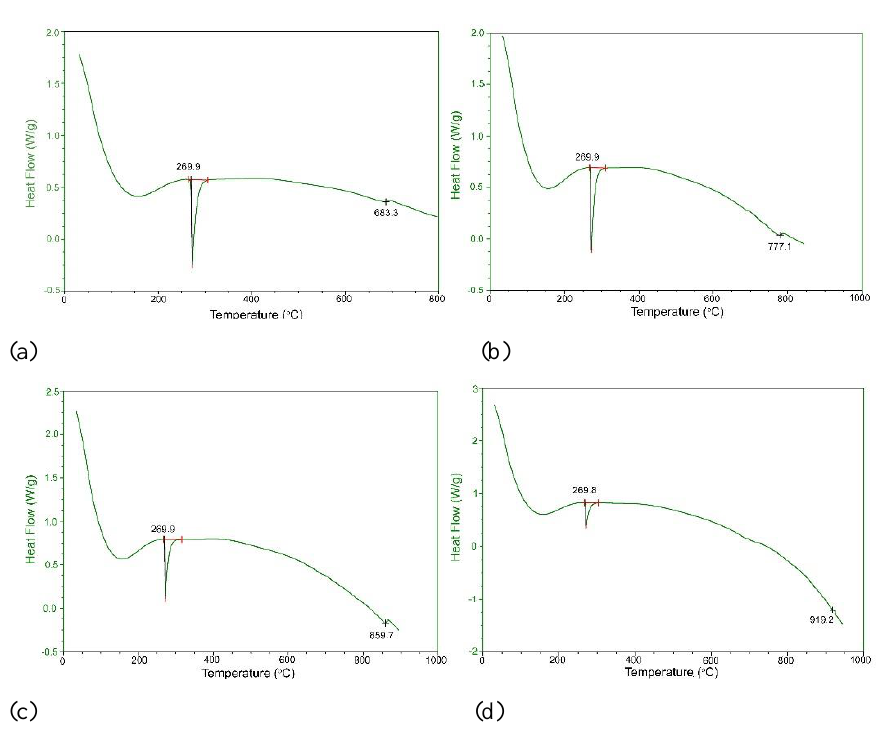
Fig. 6. DSC heating curve: (a) Bi 85.9 Cu 14.1 alloy; (b) Bi 72.5 Cu 27.5 alloy; (c) Bi 54.6 Cu 45.4 alloy; (d) Bi 30.7 Cu 69.3 alloy.